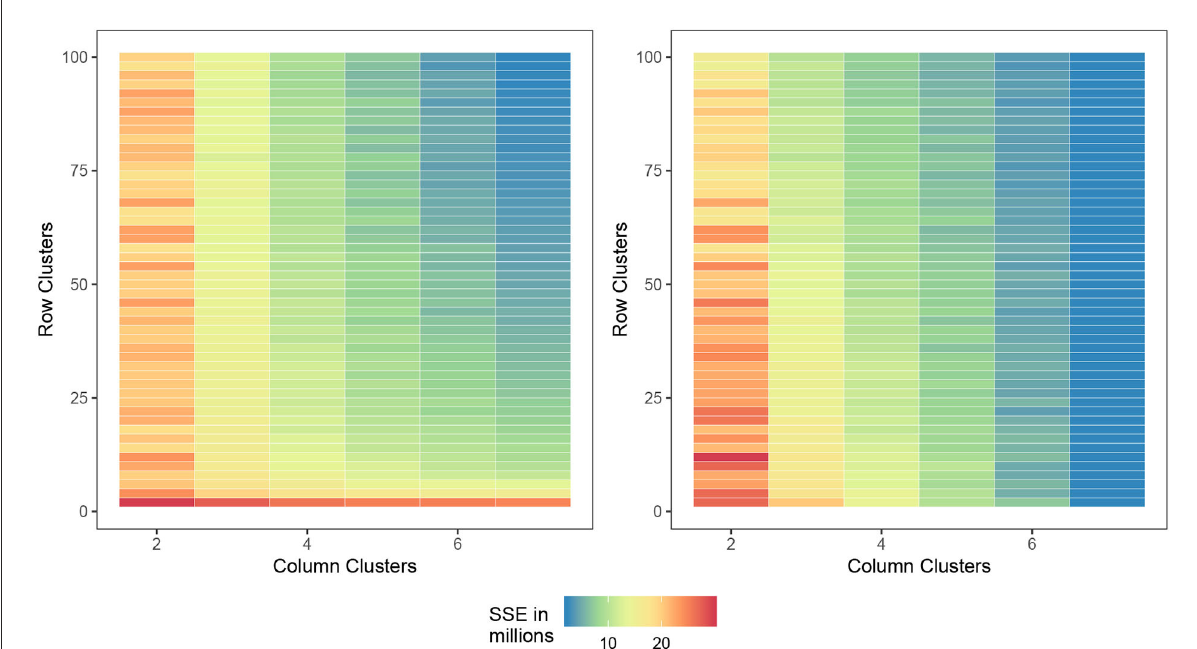
FIGURE3 Comparison of the number of row and column clusters for SSE bc (left) and SSE ni (right) as the number of column and row clusters approach the dataset dimensions, the SSE decreases toward zero.